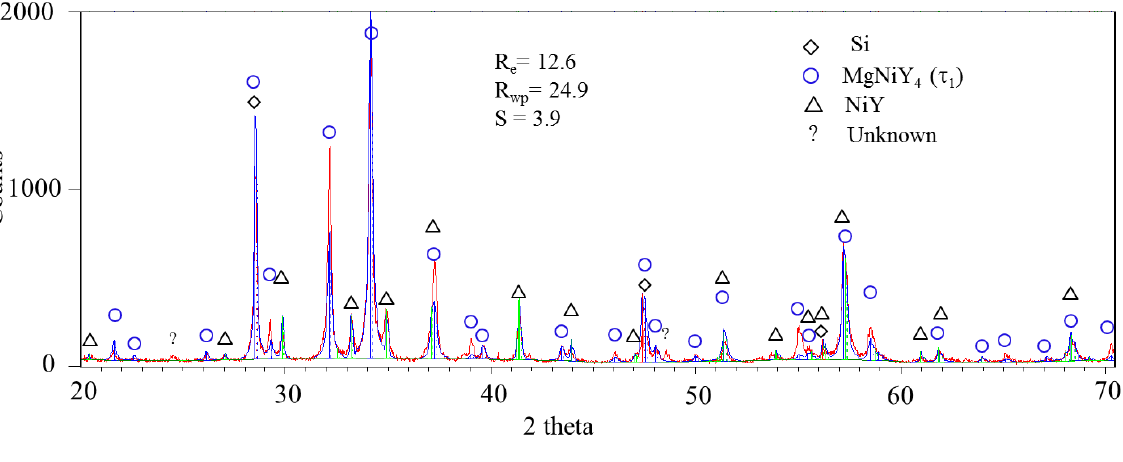
Figure 15. X-ray diffraction (XRD) pattern for sample 2 (18.5/22.4/59.1 Mg/Ni/Y